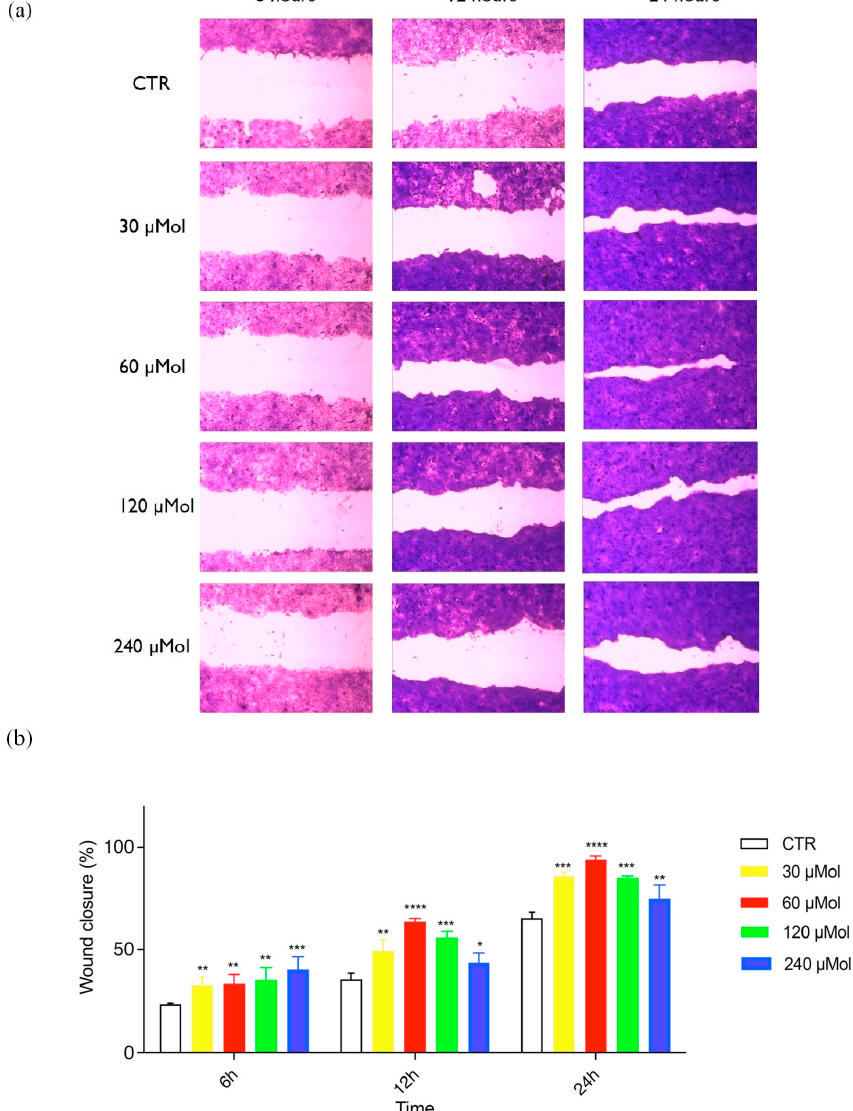
Figure 4. ( a ) Representative images of the wound field observed at 6, 12, and 24 h for untreated cells (CTR) and for cells treated with MO-07 at different concentrations (30, 60, 120, and 240 µ Mol). ( b ) Histogram plot together with ± SD of three independent experiments. * p < 0.05, ** p ≤ 0.01, *** p ≤ 0.001, and **** p ≤ 0.0001, treatments versus control (one-way ANOVA test).